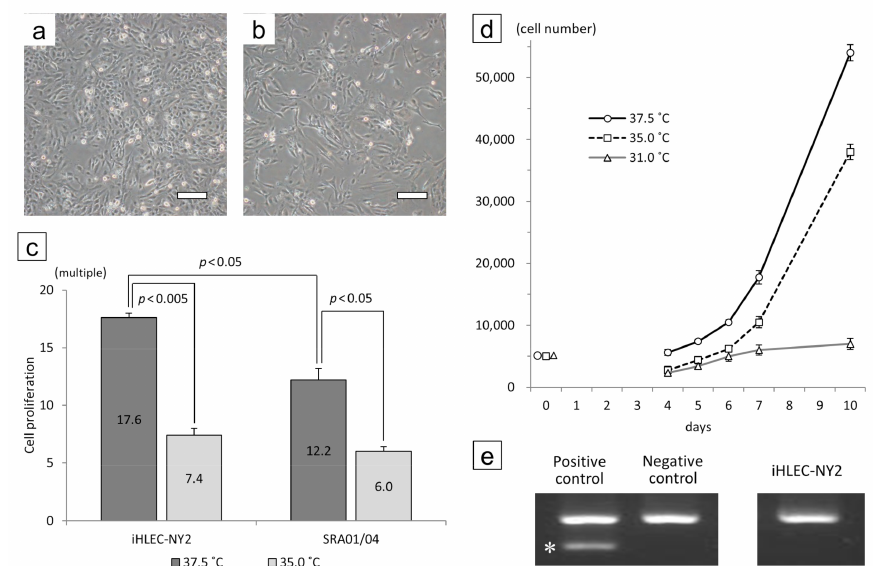
Figure 5. Cell morphology and growth rate of iHLEC-NY2 cells cultured at ( a ) 37.5 ◦ C or ( b ) 35.0 ◦ C for 7 days. Bar: 500 µ m. ( c ) The ratio of cells grown after culturing for 7 days. ( d ) Growth curves of iHLEC-NY2 cells at di ff erent temperatures. ( e ) The result of the iHLEC-NY2 mycoplasma infection PCR test was negative. * Positive band.